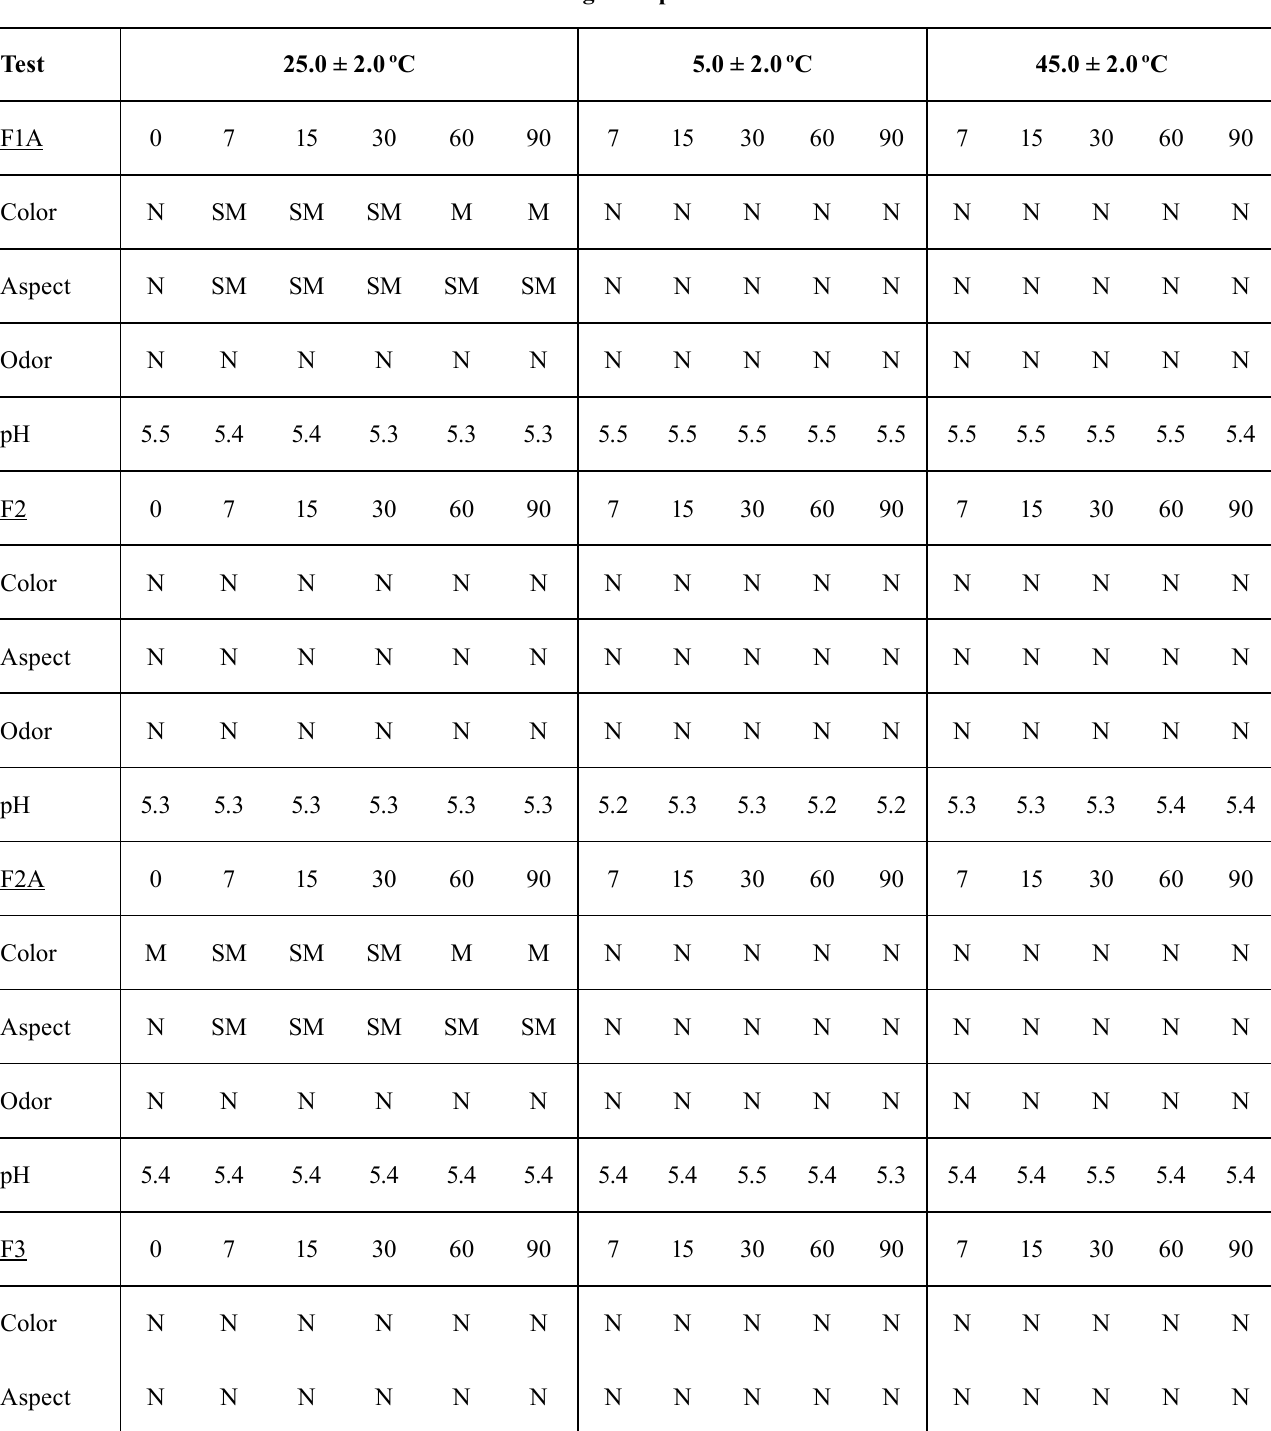
TABLE III – Organoleptic characteristics (aspect, color and odor) and pH value submitted to the Normal Stability Assessment ( NSA ) during the 90